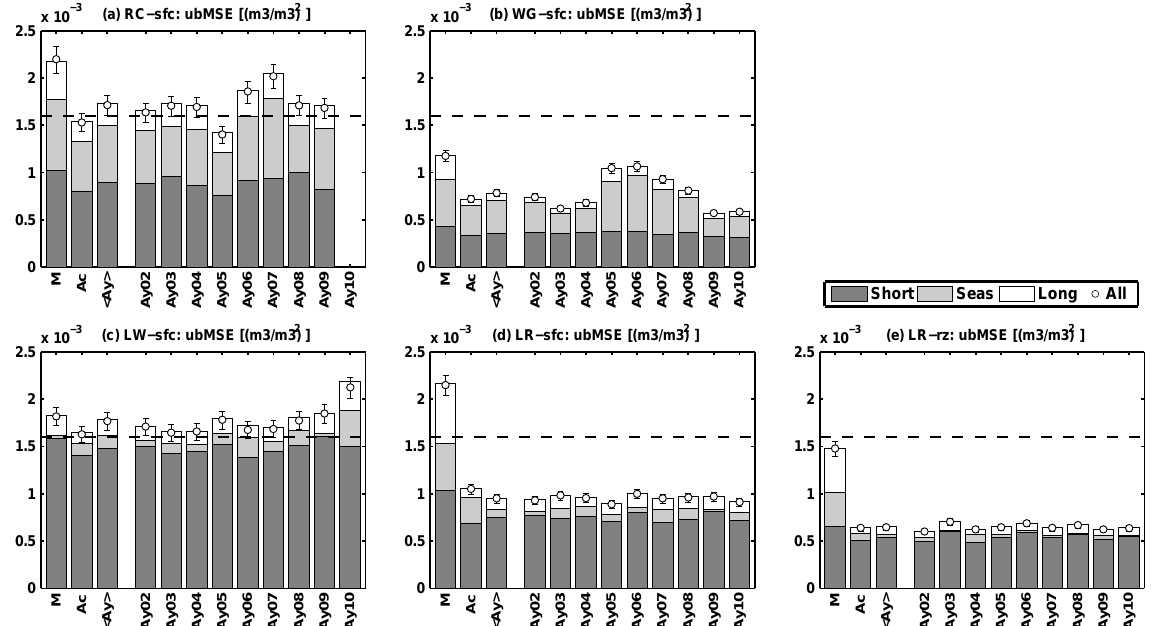
Figure 5. Error variances (ubMSE) compared to ARS in situ observations at each timescale, for the near-surface soil moisture at (a) Reynolds Creek, (b) Walnut Gulch, (c) Little Washita, (d) Little River, and (e) for the root-zone soil moisture at Little River. Bars show the Catchment model open loop (M), baseline assimilation (Ac), individual Ay assimilation experiments, and the mean across the Ay experiments ( (cid:104) Ay (cid:105) ). Label AyYY indicates the Ay experiment with bias correction parameters estimated from the 12 months from 1 October of 20YY. Circles and error bars give the ubMSE and its 95% confidence interval for the original soil moisture time series (some very small confidence intervals are obscured by the plotted circles). The dashed line at ubMSE of 1.6 × 10 − 3 (m 3 m − 3 ) 2 is equivalent to the common ubRMSE target of 0.04m 3 m − 3